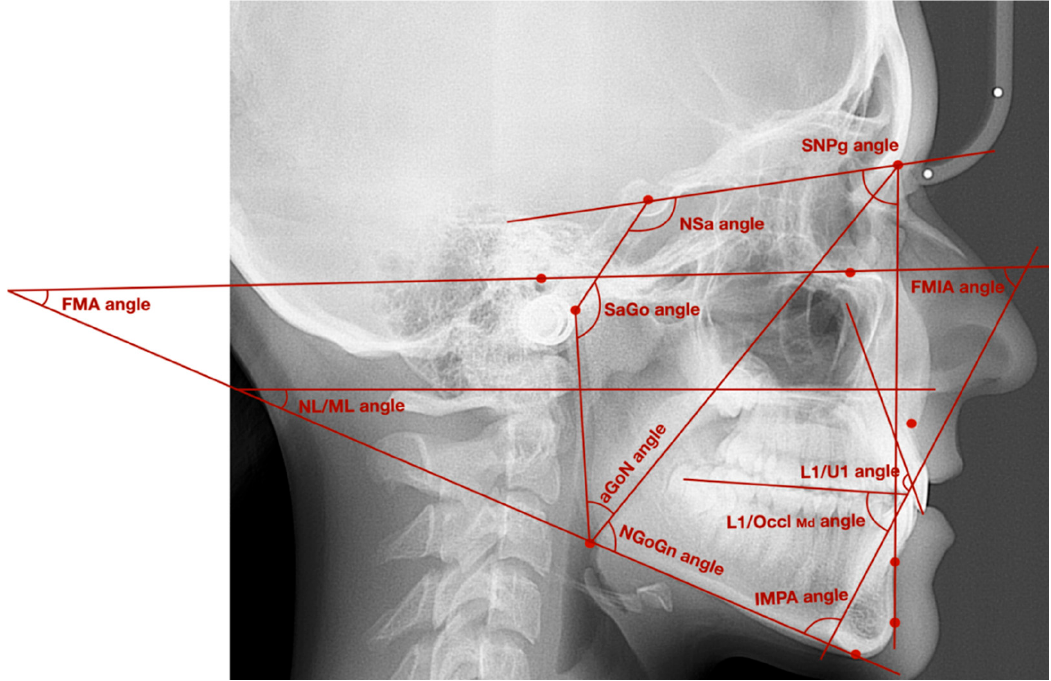
Figure 2. Exemplary lateral cephalogram with marked angles described in Table 2.